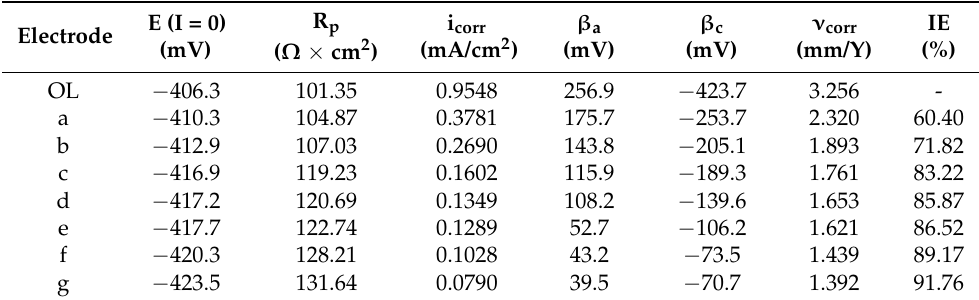
Table 3. The Tafel parameters calculated for the protected electrodes immersed in 0.1 M HCl medium for 30